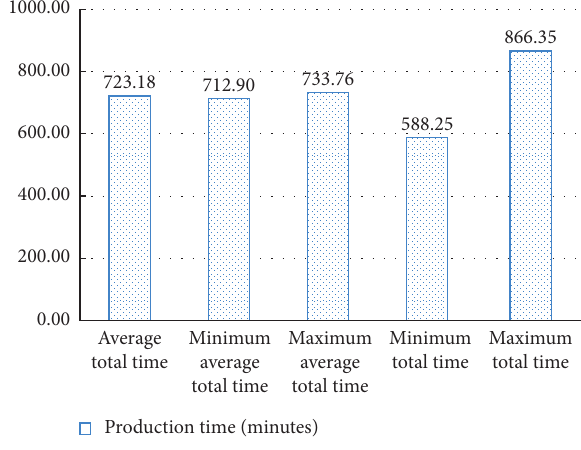
Figure 8: Production time for 43 semiprecast slabs. Table 4: Instantaneous utilization of each resource after 1500